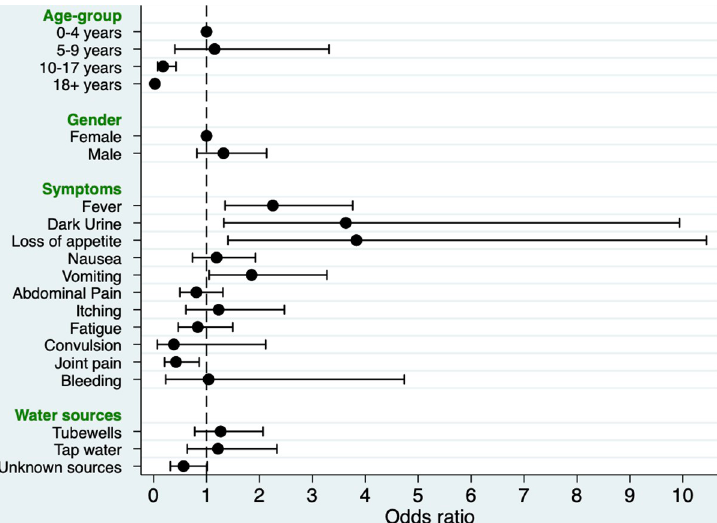
Fig 5. Odds ratio for the association of hepatitis A seropositivity with age-group, gender, presenting symptoms and drinking water sources.